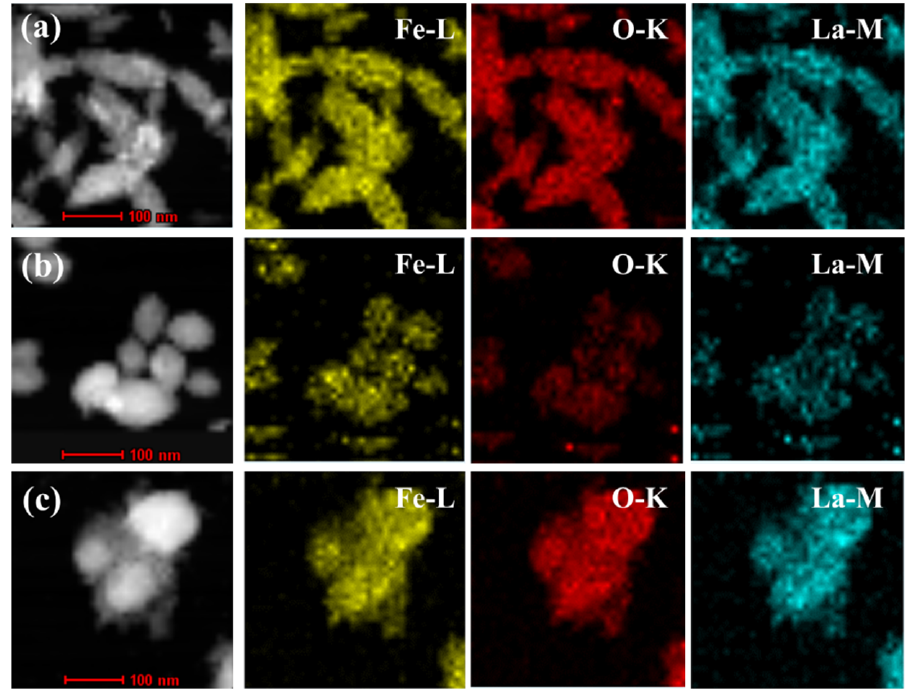
Figure 4. TEM-EDS mapping images of La-doped α -Fe 2 O 3 (x) (x = 4, 6, 8). ( a ) La-doped α -Fe 2 O 3 (4); ( b ) La-doped α -Fe 2 O 3 (6); ( c ) La-doped α -Fe 2 O 3 (8). ( b ) La-doped α -Fe 2 O 3 (6); ( c ) La-doped α -Fe 2 O 3